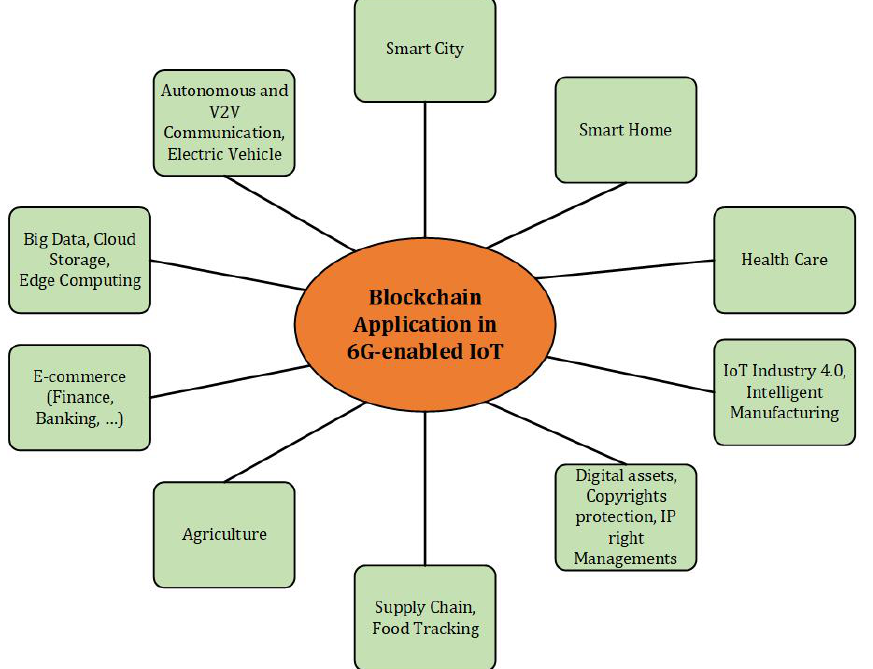
Figure 4. Blockchain applications in 6G-enabled